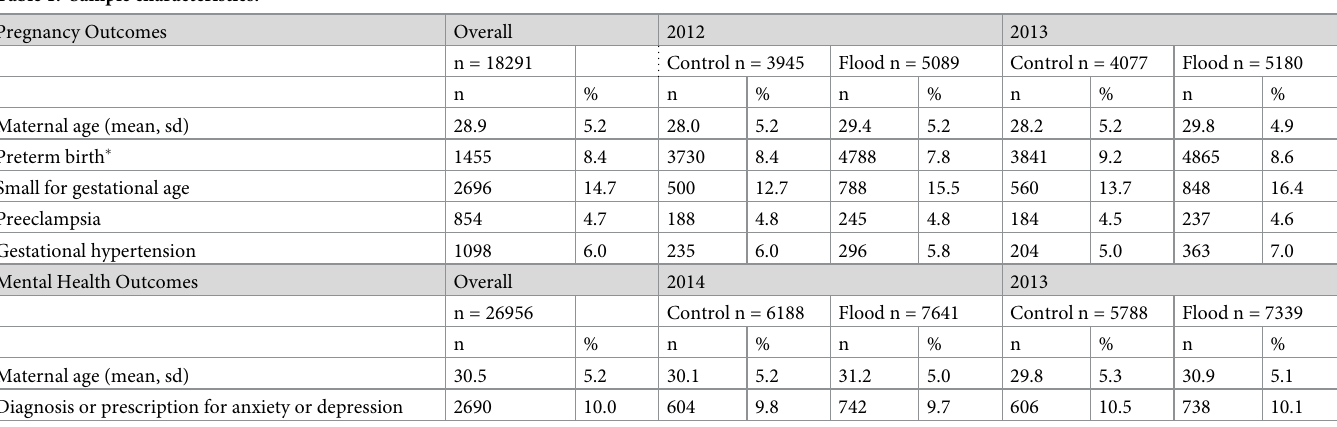
Table 1. Sample characteristics.